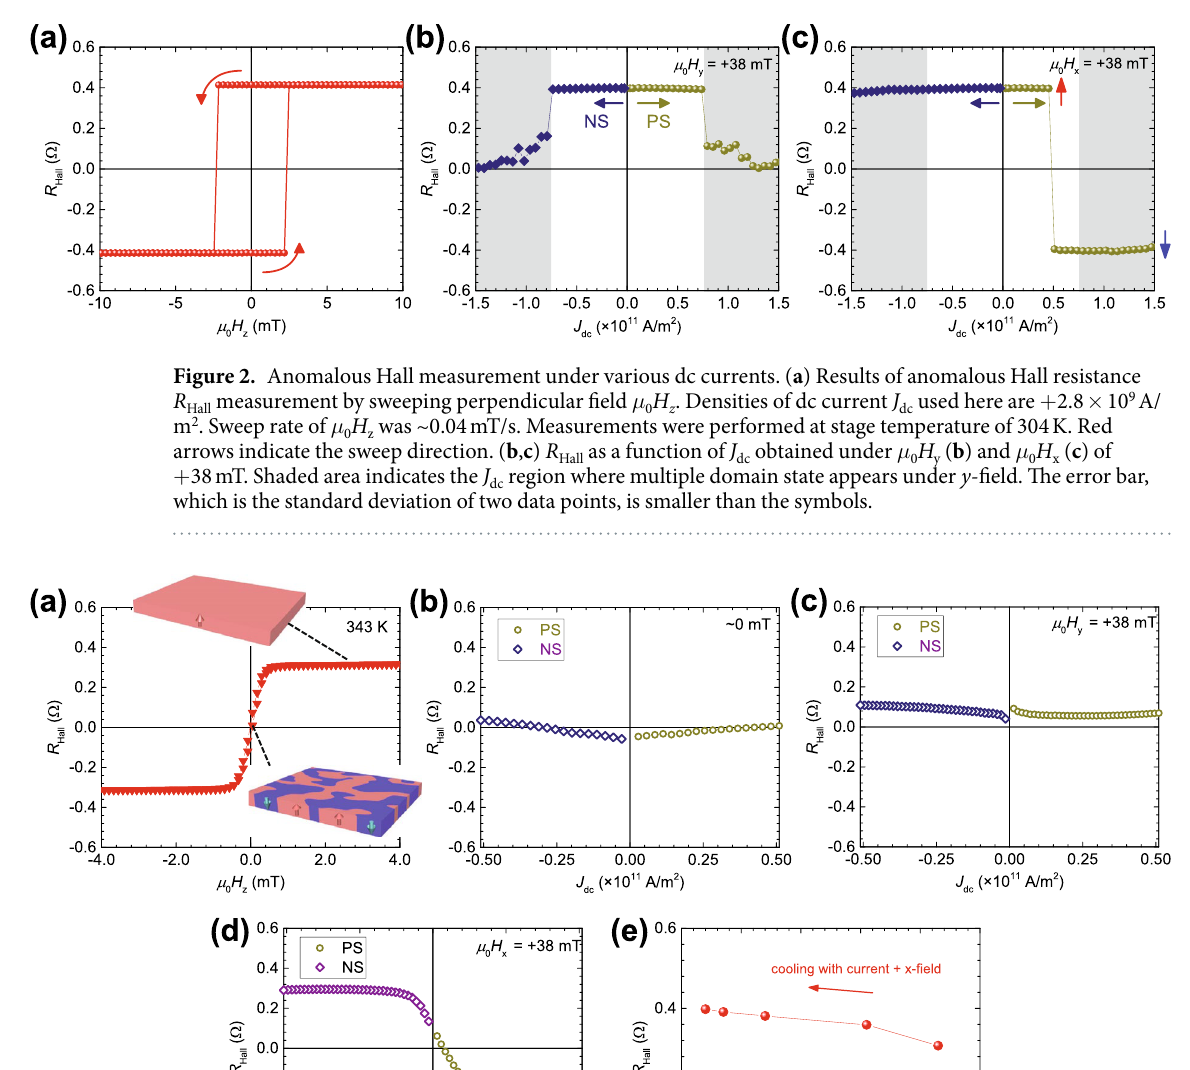
small. In this case, an anhysteric R Hall curve with the almost zero remanent is observed. This indicates that the MD state is realized and the system is demagnetized. Figure 3b shows R Hall as a function of J dc obtained under μ 0 H z of ~0 T. R Hall is almost independent of J dc in the range of ± 0.5 × 10 11 A/m 2 . Similarly, no change in R Hall is observed for a μ 0 H y of + 38 mT, as shown in Fig. 3c. The slight R Hall deviation from zero is probably due to the small z -component of the field. The slight J dc dependence on R Hall shown in Fig. 3b and c might be a result of the Oersted field. Based on these results, it can be concluded that in both cases, the MD state is kept under current injection. The result obtained under μ 0 H x = + 38 mT is completely different, as shown in Fig. 3d. For a small J dc , R Hall showed an intermediate value, indicating that the MD state remains. However, a clear increase and decrease in R Hall with increasing current toward the negative and positive magnetization directions, respectively, are observed. For both current directions, R Hall saturates above | J dc | = 0.1–0.2 × 10 11 A/m 2 and the R Hall saturation values are consistent with those for the SD state. This result indicates that magnetization process of the system is caused by the SOT.